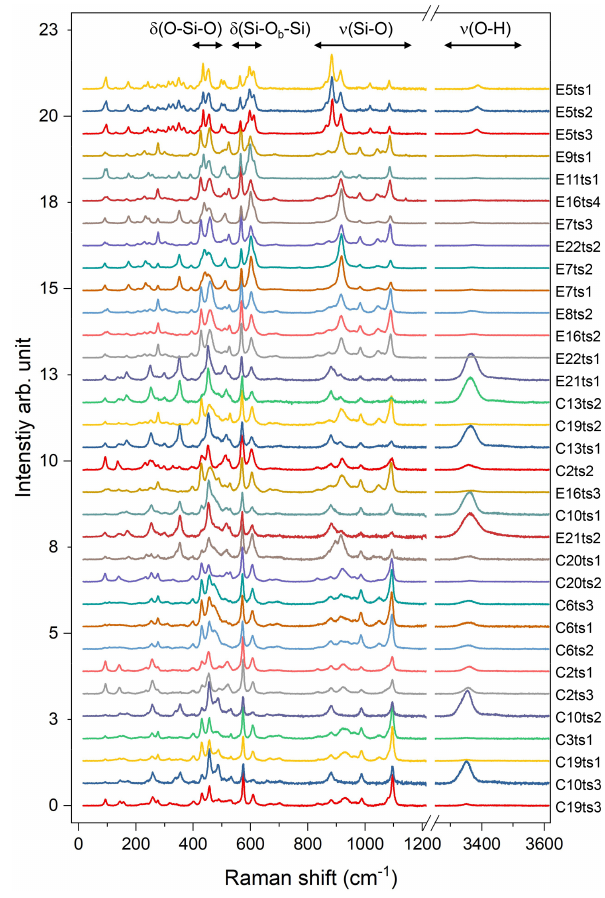
Figure 5. Raman spectra of the studied Al–Fe 3 + series of epidote- group minerals. The Fe content increases from the bottom to the top; the orientation of the grains is random. For better comparison, the spectra were normalized to the height of the strongest peak and ver- tically offset. Spectra labelling corresponds to the analytical points listed in Table 2 and indicated in Fig.